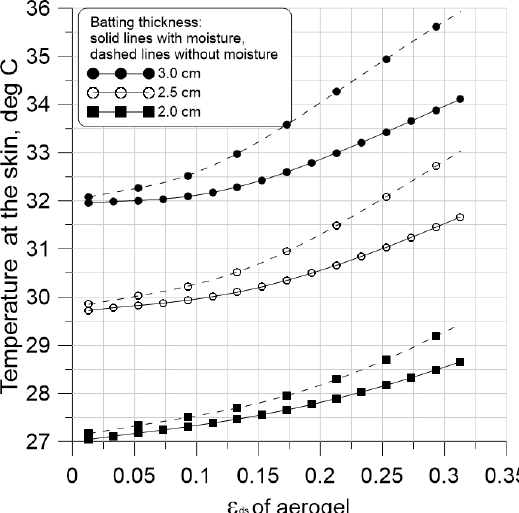
Figure 12. Influence of the volume fraction of aerogel ε ds on the temperature on the human skin at different thicknesses of the insulating layer, taking into account (solid lines) and without taking into account (dotted lines) the transport of humidity inside